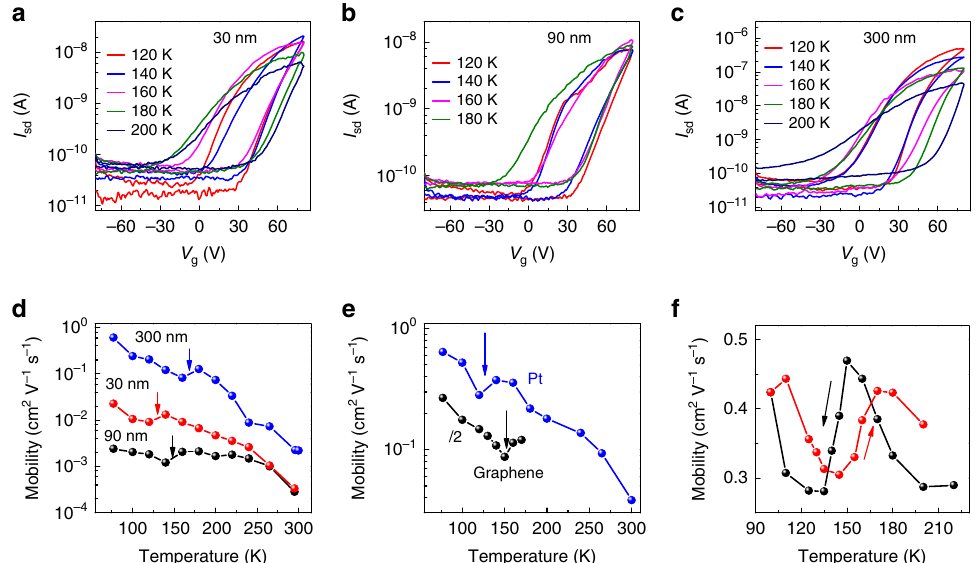
Figure 2 | Size-dependent transition of the orthorhombic phase to tetragonal phase. ( a – c ) The temperature-dependent transfer characteristics of field- effect transistors made of 30nm ( a ), 90nm ( b ) and 300nm ( c ) thick individual perovskite crystal microplates. The applied source-drain voltage is 20V and the channel length is 8 m m. ( d ) The temperature-dependent field-effect electron mobility for three different thickness devices extracted from a – c . The arrows indicate the temperature where the phase transition occurs. The mobility is measured for the heating cycle. ( e ) The temperature-dependent field- effect electron mobility for devices with Pt contact and graphene contact. The thickness of the microplates is around 35nm and the channel length is 40 m m for Pt contact. For graphene contact, the thickness of the microplates is around 120nm and the channel length is around 15 m m. The mobility is measured during the heating cycle. ( f ) The temperature-dependent field-effect mobility of a perovskite microplate device (5nm Cr/50nm Au as contact) with a thickness of around 200nm measured for both heating and cooling cycle under a source-drain voltage of 20V. The channel length of the device is 40 m m.